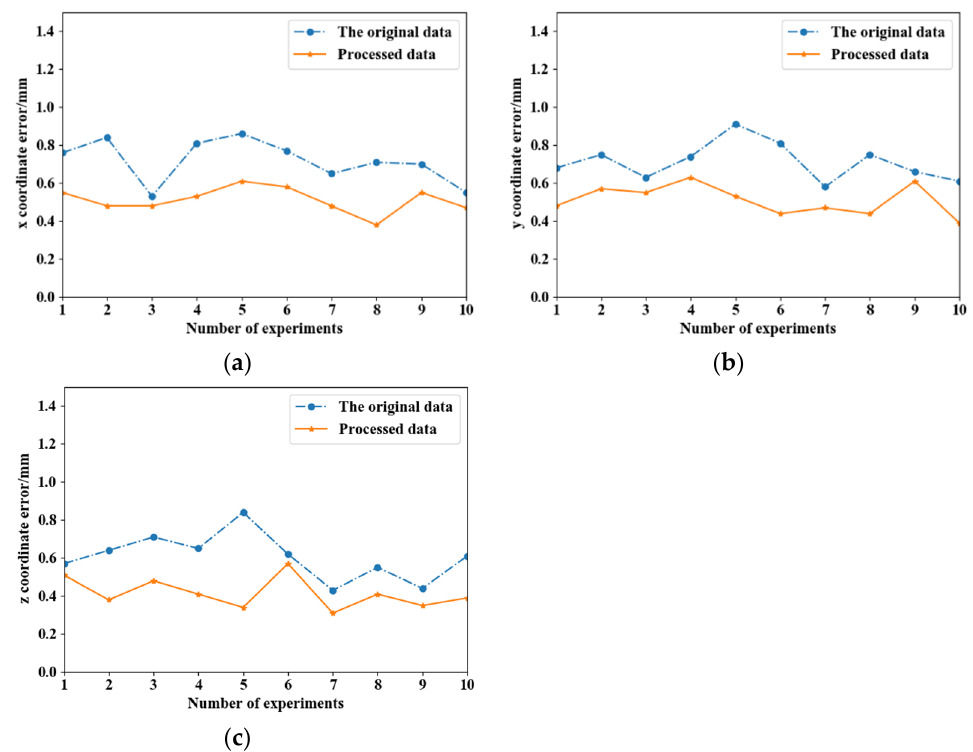
Figure 14. Reprojection error: ( a ) X coordinate reprojection error; ( b ) Y coordinate reprojection error; ( c ) Z coordinate reprojection error.